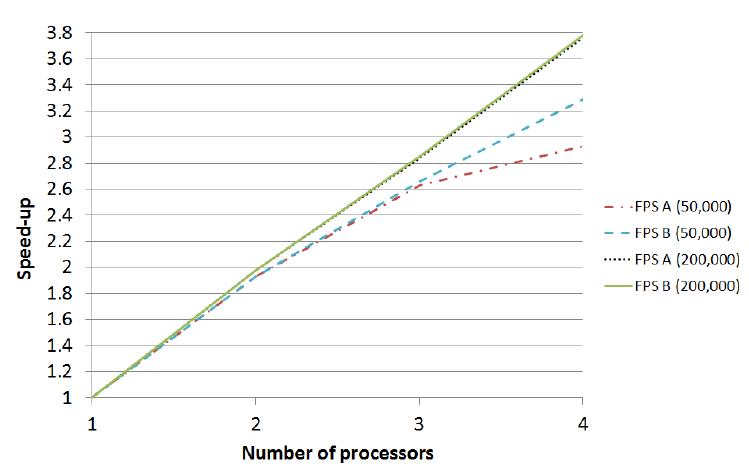
Figure 3. Speedup